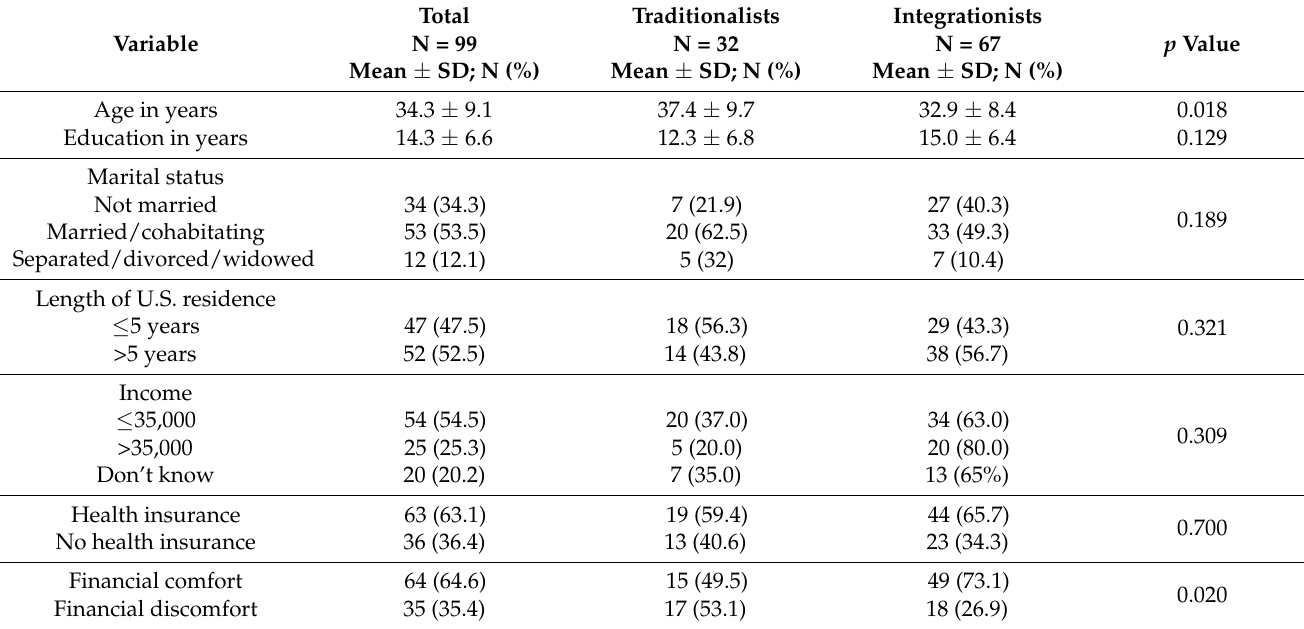
Table 1. Sample characteristics by acculturation strategy (N =